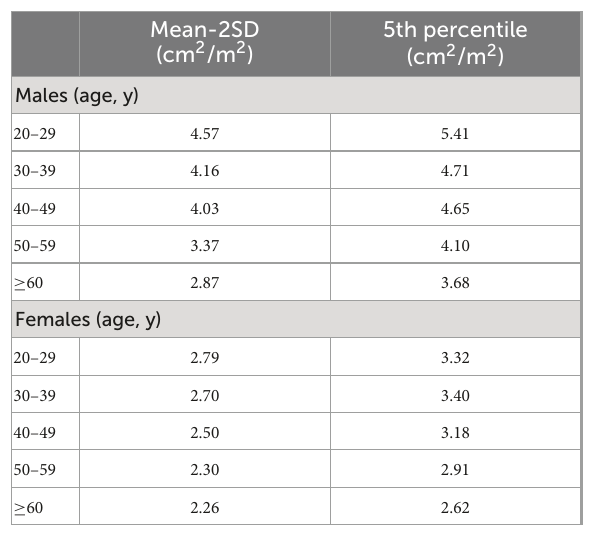
L3-PMI reference values and the Japan Society of